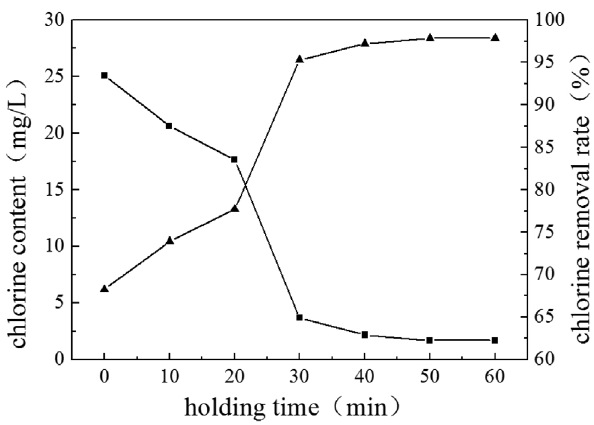
Fig. 6: Effect of holding time on chlorine content and Cl removal rate